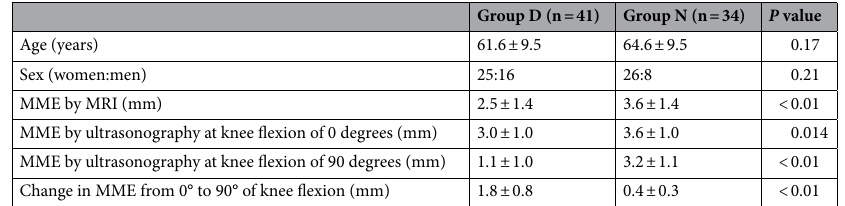
Table 1. MRI and ultrasonography measurements of MME in the two groups. MME medial meniscal extrusion, MRI magnetic resonance imaging.